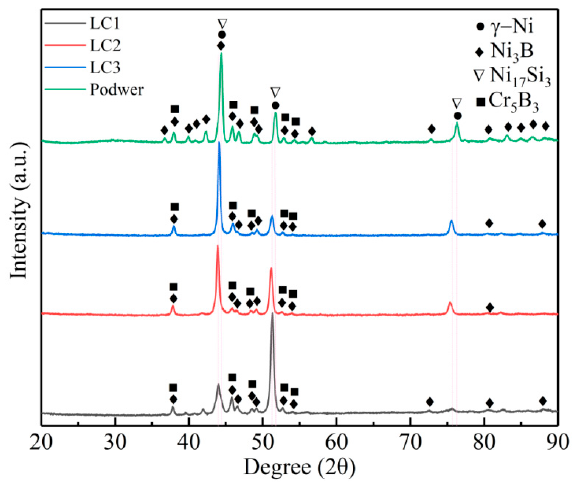
Figure 6. XRD patterns of powders and three cladding